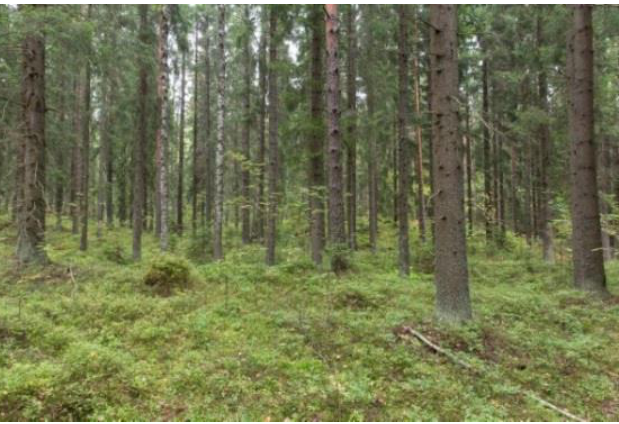
Figure 3. The mature commercial forest (Mature). This picture was published in Reference [66].